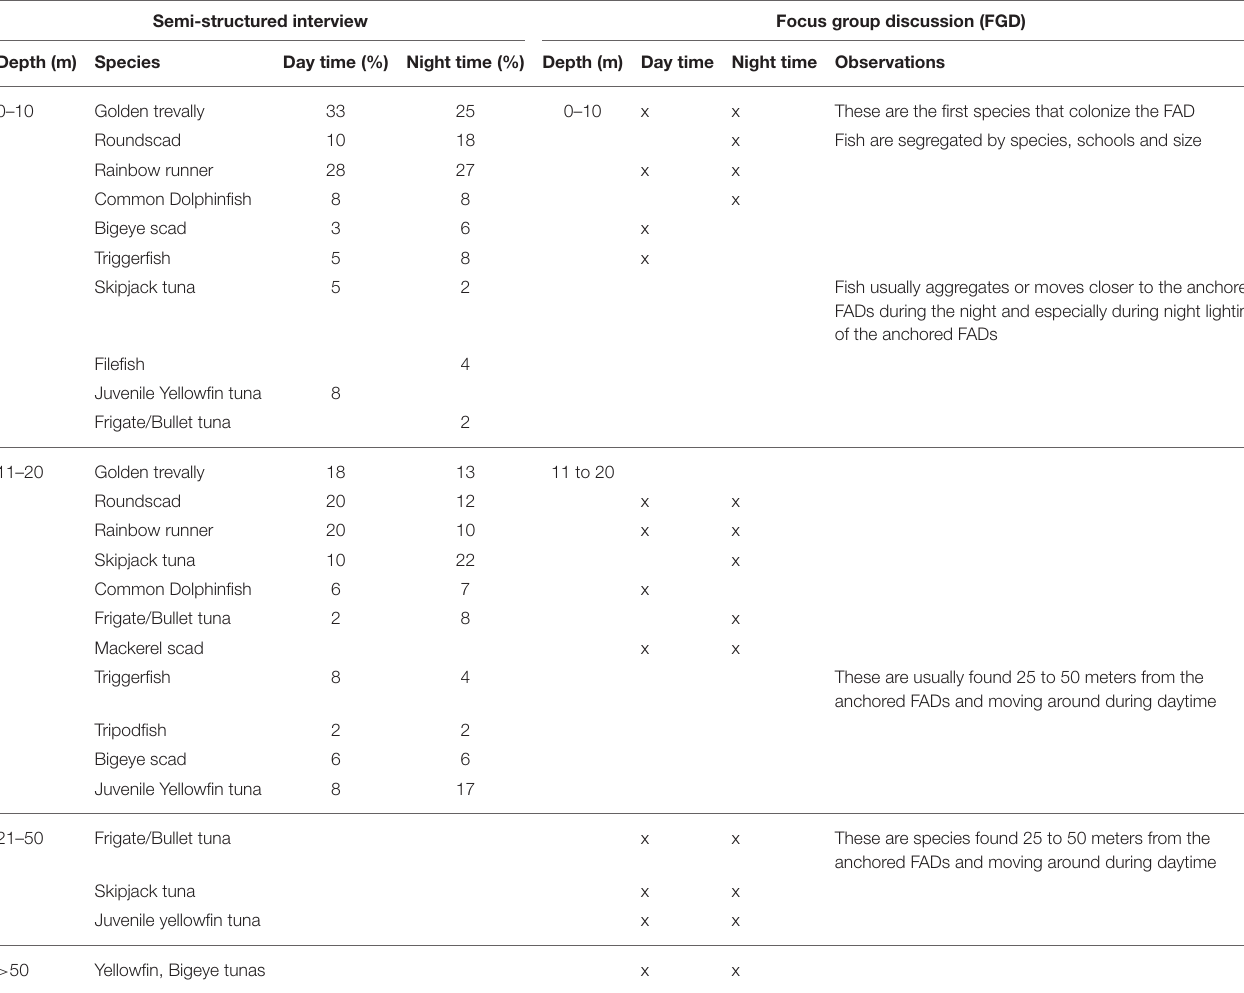
TABLE 4 | Depth distribution of fish species on anchored FADs during day time and night time based on semi-structured interviews ( n = 46) and based on three FGDs ( n = 39).